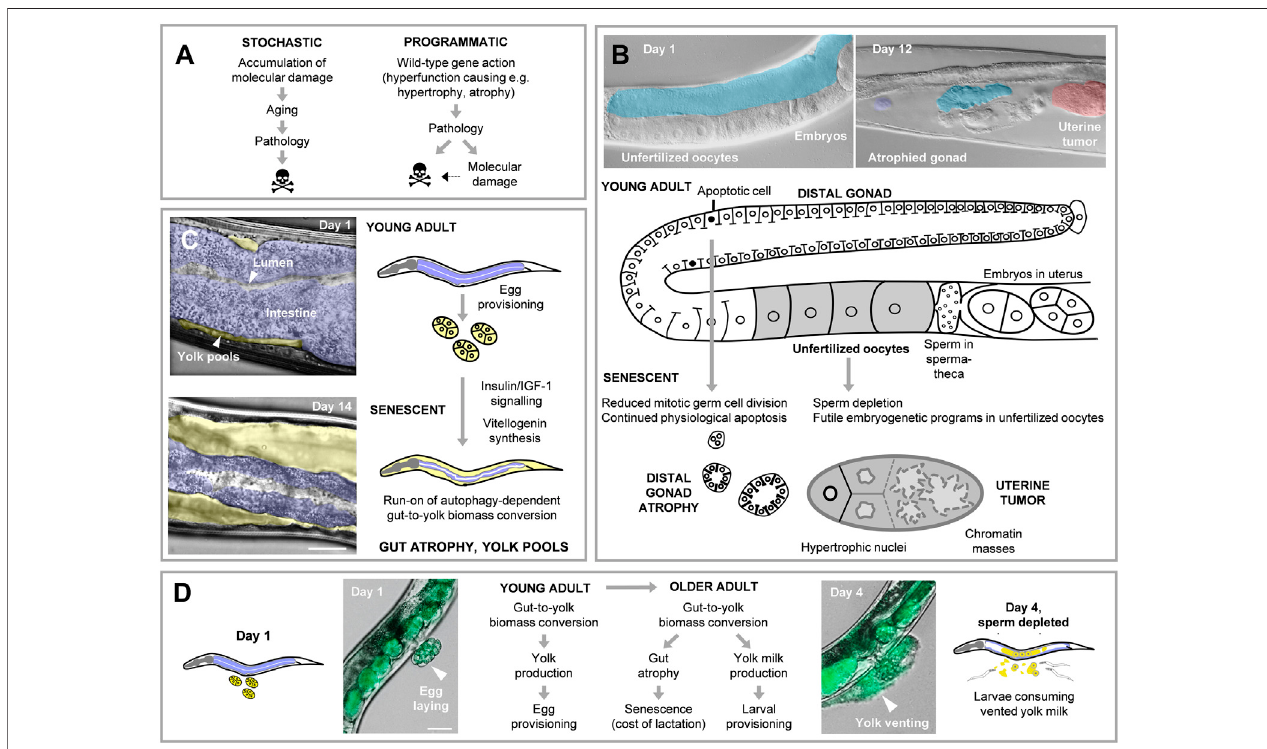
FIGURE 1 | Programmatic mechanisms of aging are a cause of senescent pathology in C. elegans . (A) Stochastic and programmatic models of aging. These are not mutually exclusive, and are elements of a wider, multifactorial aging process (Gems, 2022). (B) Quasi-programs promote distal gonad atrophy and uterine tumor development. Futile run-on ofphysiologicalapoptosis promotes distal gonad atrophy and fragmentation (de la Guardia et al., 2016),along withdepletion ofthegermline stem and progenitor cell pools (Tolkin and Hubbard, 2021). An embryogenetic quasi-program causes unfertilized oocytes to develop into teratoma-like uterine tumors (Wang et al., 2018). Blue, distal gonad. Red, uterine tumor. (C) Intestinal biomass repurposing supports yolk synthesis (vitellogenesis), whose seemingly futile run-on leads to intestinal atrophy (Ezcurra et al., 2018). Violet, intestine. Yellow, yolk pools in body cavity. (D) Intestinal atrophy as a cost of lactation. The recent demonstration that yolk isvented, and of promotion of larval growth by vented yolk, implies that later yolk production is not futile run-on, and that gut atrophy isa cost of lactation (Kern et al.,